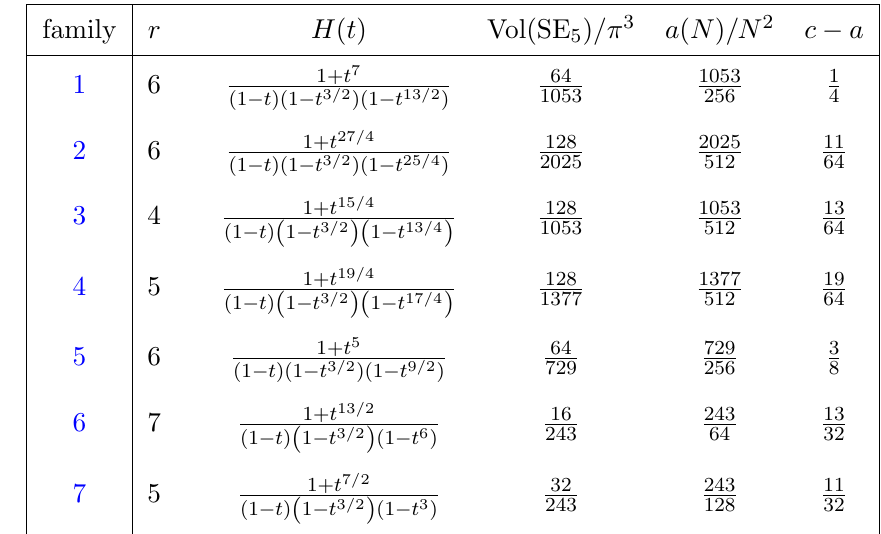
Table 3 . We collect the large- N Hilbert series, the volume of the ((cid:12)ve-dimensional internal space of the) putative gravity dual AdS 5 (cid:2) B 5 , the a central charge, and the gravitational anomaly for the seven in(cid:12)nite families of 4d models obtained from the 3d ones (by forgetting the CS interactions and replacing U with SU). The total number of gauge groups is related to the chosen value of r , as explained in appendix